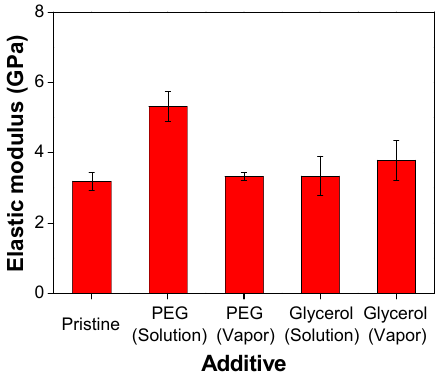
Figure 3. Elastic modulus of Pristine, PEG solution-treated, PEG vapor-treated, glycerol solution-treated, and glycerol vapor-treated films.